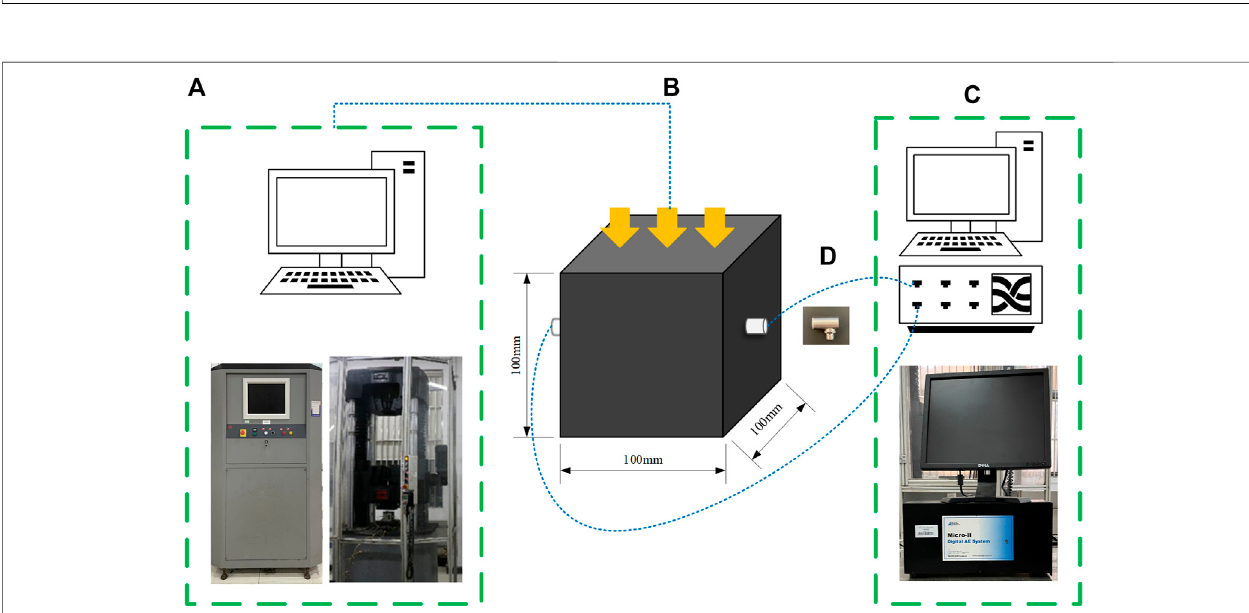
FIGURE 2 | Diagram of uniaxial compression (A) electronic universal testing machine; (B) coal sample and location of acoustic emission probe; (C) acoustic emission monitoring system; (D) acoustic emission probes.